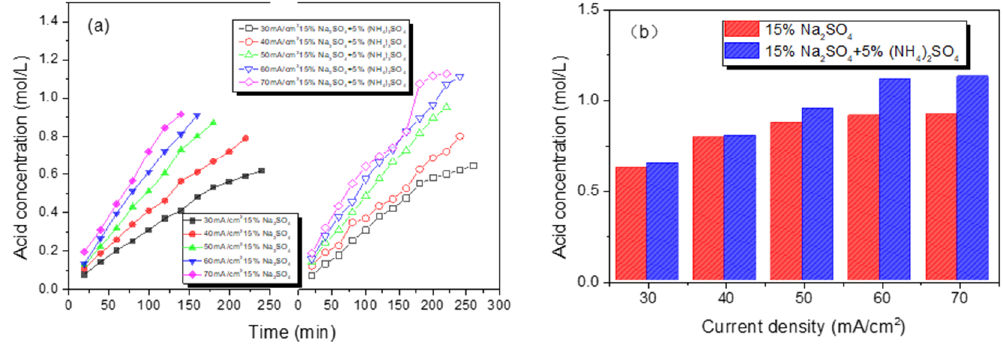
Figure 4. Production of H 2 SO 4 ( a ) before and after adding (NH 4 ) 2 SO 4 with different current densities ( b